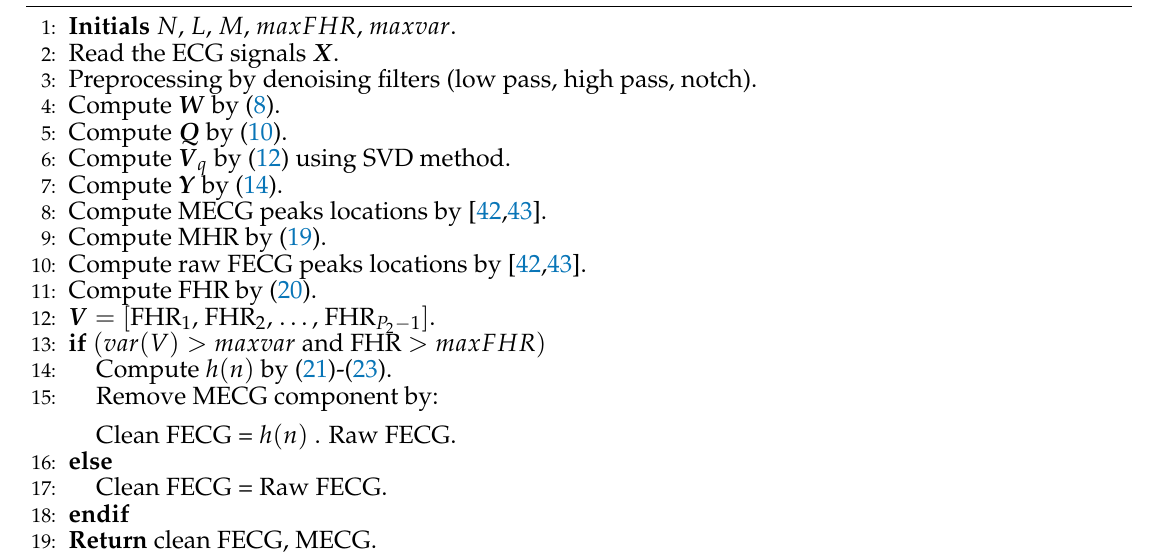
Algorithm 1 The proposed NSITM extraction